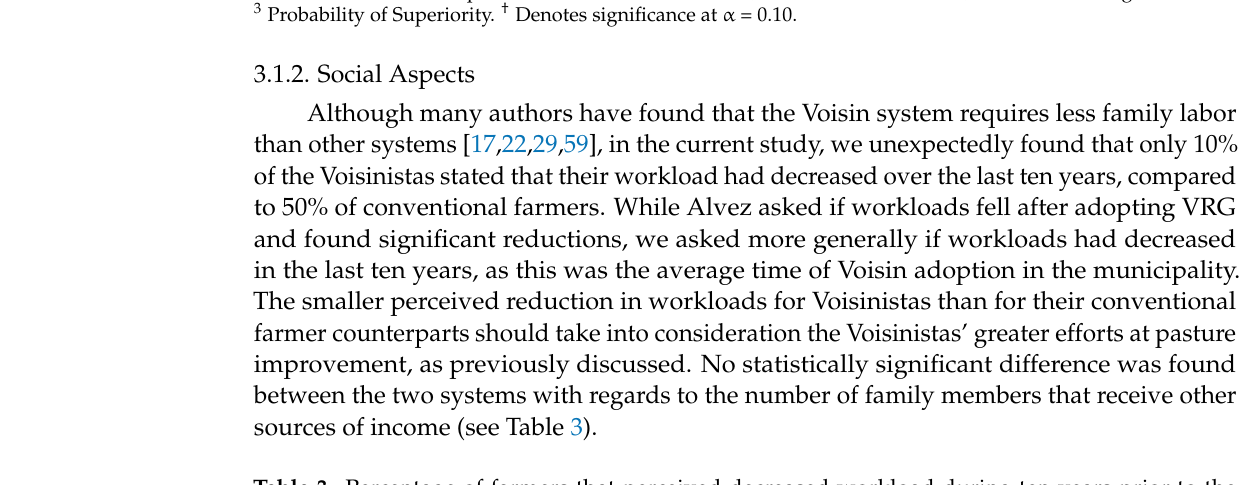
Table 3. Percentage of farmers that perceived decreased workload during ten years prior to the interview, and the average of family members receiving income from sources other than dairy